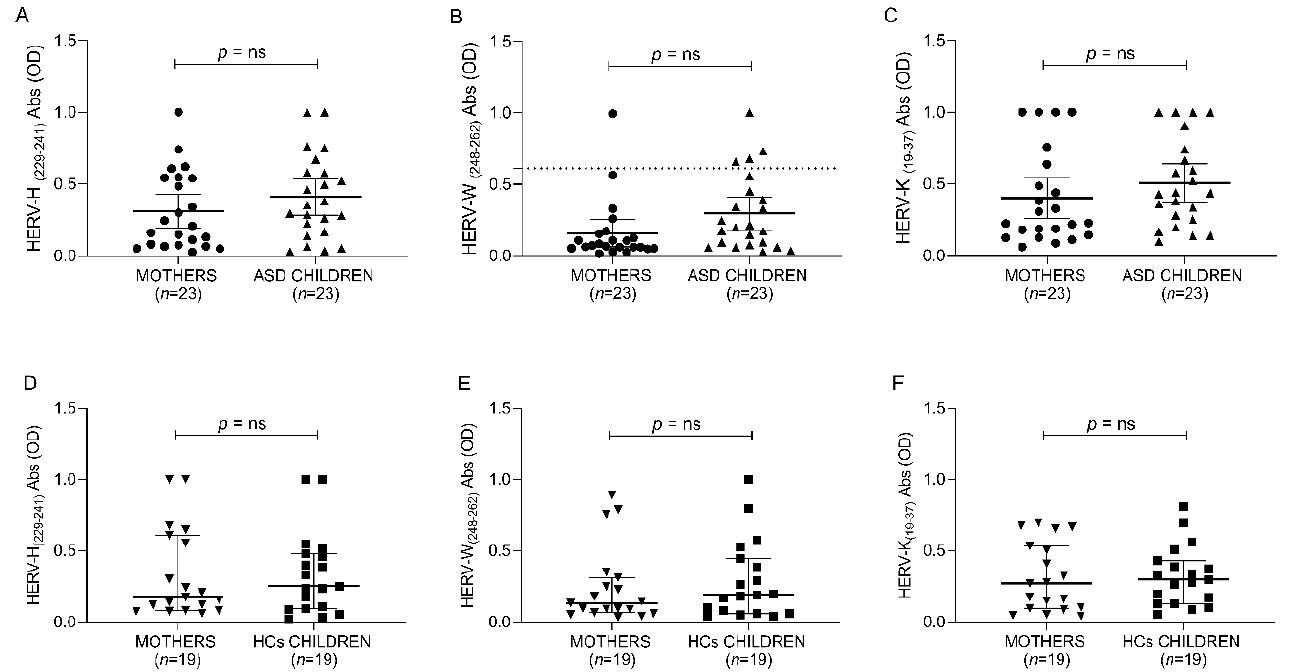
Figure 3. ELISA-based analysis of antibody presence against HERV-H-, HERV-W- and HERV-K- derived epitopes. Plasma samples from ASD and HCs populations were tested against HERV-H (229–241) ( A , D ), HERV-W (248–262) ( B , E ) and HERV-K (19–37) ( C , F ). Scatter plots represent median with 95% of CI. The Mann–Whitney p -value is indicated in the upper part of each graph. Table 7. ANOVA group comparisons of anti-HERV-env levels between mothers and children of both groups.